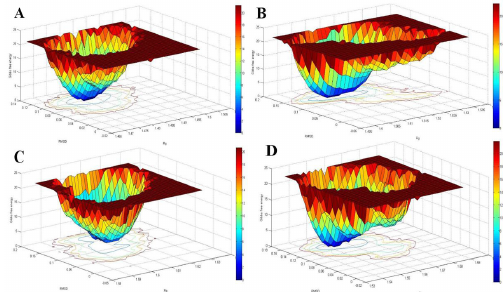
Figure 6: Free Energy Landscape of the A , B , C and D simulated